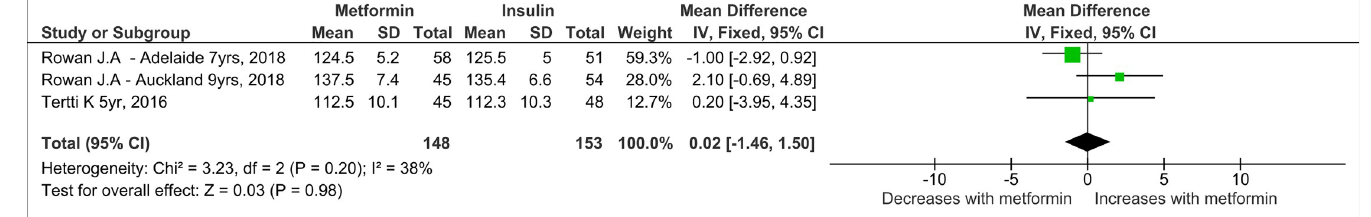
PLOS Medicine| https://doi.org/10.1371/journal.pmed.1002848 August 6,